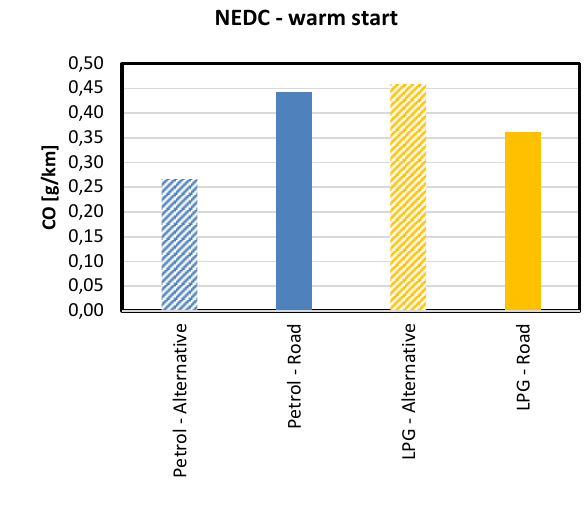
Fig. 12. Impact of resistance forces on CO emissions for NEDC tests